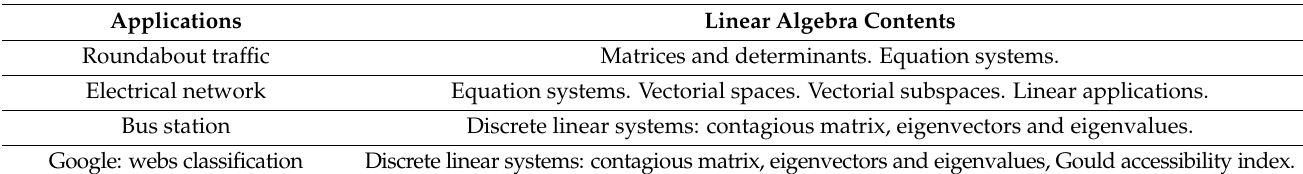
Table 3. Session 2 (“Network flows”) from the seminar of contextualization of mathematics in engineering degrees.